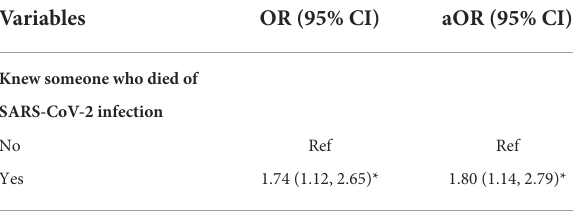
TABLE 3 Associations between knowing someone who died of SARS-CoV-2 infection and sleep duration, September 2020 ( n = 1,058) Odds Ratio (95% CI).